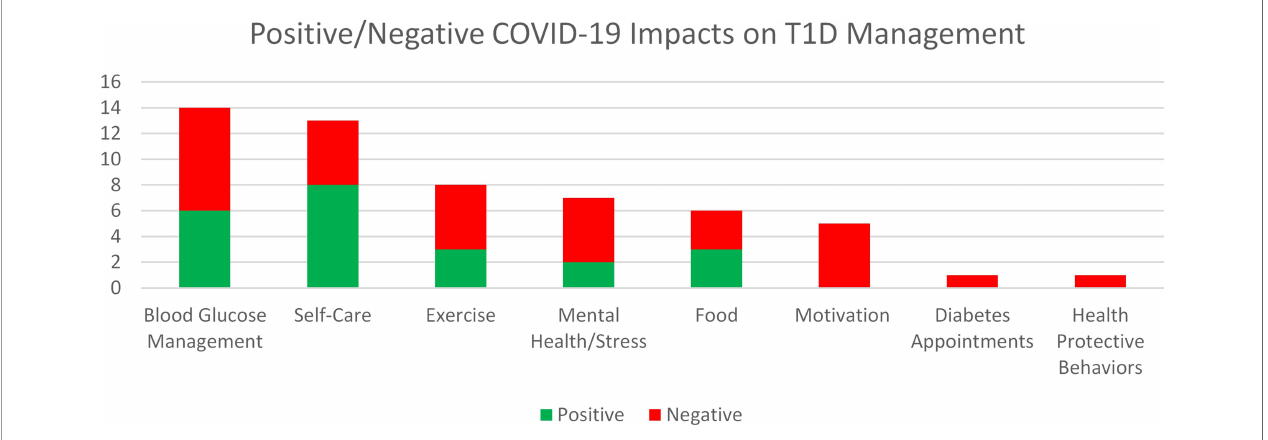
FIGURE 5 | Positive and negative teen comments about COVID-19's impact on Type 1 Diabetes management. Numbers shown are